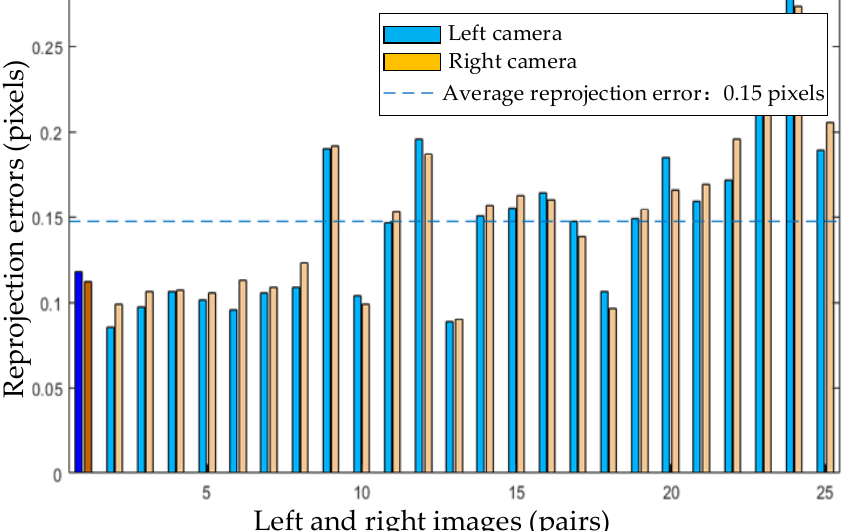
Figure 11. Binocular vision system.